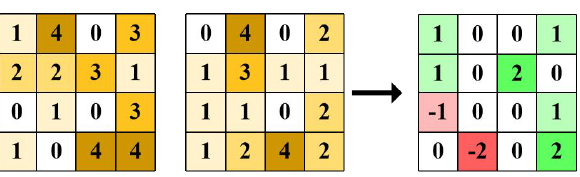
Figure 3 . DEM difference analysis schematic